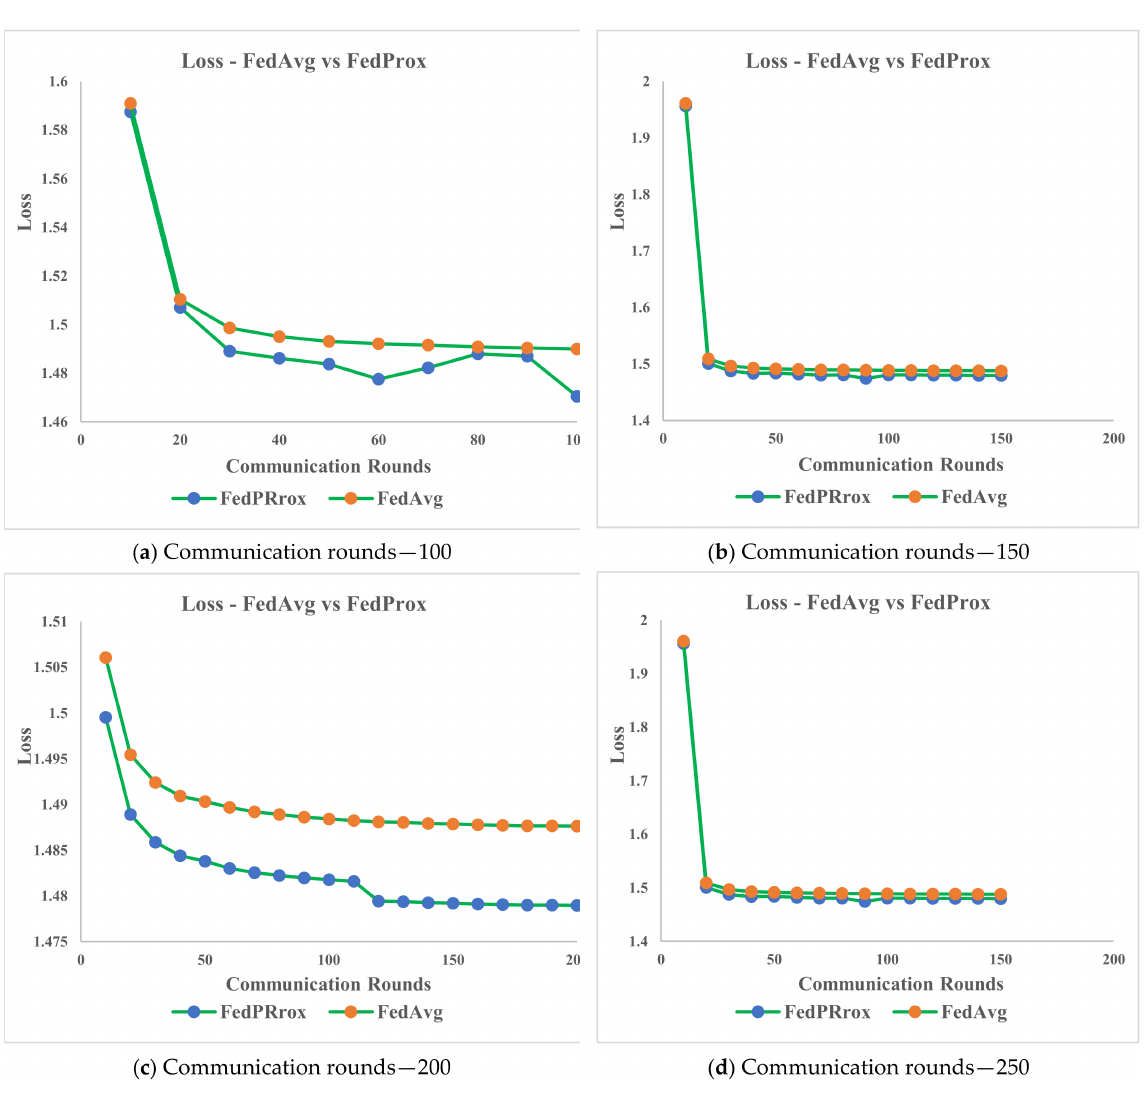
Figure 10. FedAVg vs. FedProx—loss. Table 5. FedAvg vs.